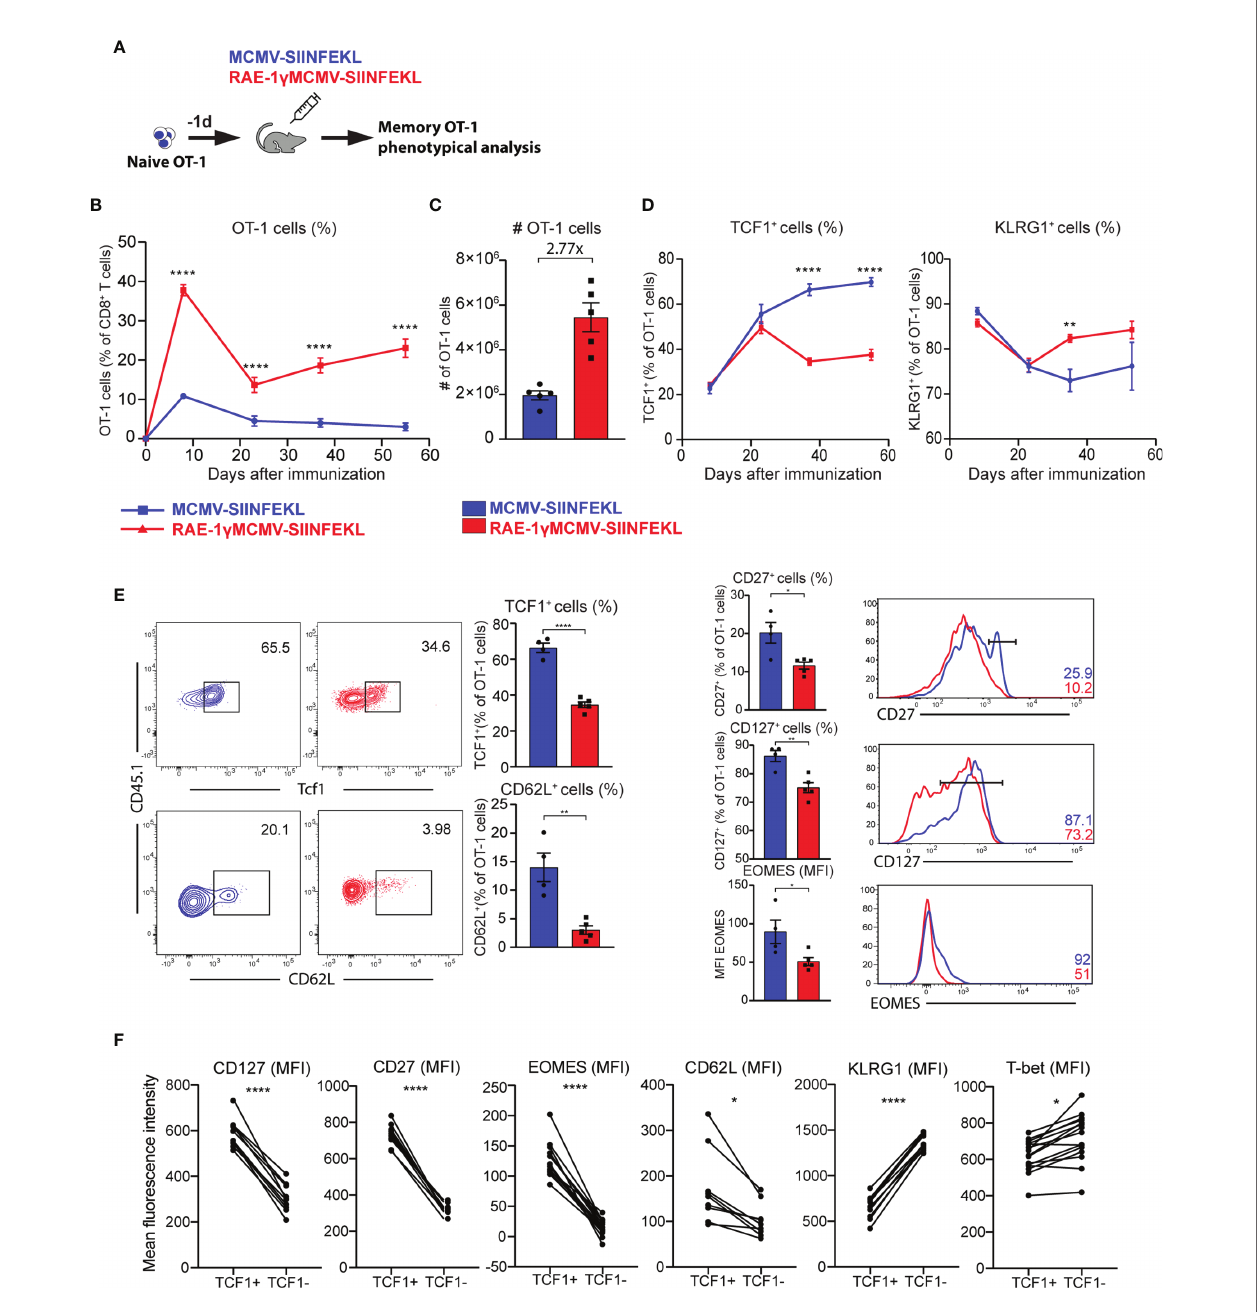
FIGURE 3 | RAE-1 g MCMV-SIINFEKL has superior priming capacity and generates phenotypically distinct memory CD8 T cells. (A) 10 4 naive OT-1 cells were transferred to C57BL/6J mice one day prior to immunization with MCMV-SIINFEKL or RAE-1 g MCMV-SIINFEKL (n=4-5). (B) OT-1 frequency (blood) at indicated time points post-immunization. (C) Absolute numbers of OT-1 cells at day 7 post-immunization in the spleen. (D) Kinetics of TCF1 + and KLRG1 + populations were followed in blood over time. (E) The phenotype of memory OT-1 cells primed with indicated viruses at day 37 post-immunization shown as the percentage of TCF1 + , CD62L + , CD27 + , CD127 + OT-1 cells, and MFI of Eomes on OT-1 cells. (F) Expression of indicated molecules on TCF1 + and TCF1 - cells. Data are from a single experiment representative of two independent experiments. Data are represented as mean ± SEM and statistical signi fi cance as *p < 0.05, **p < 0.01, ****p<0,0001. Statistical signi fi cance was determined using unpaired Student